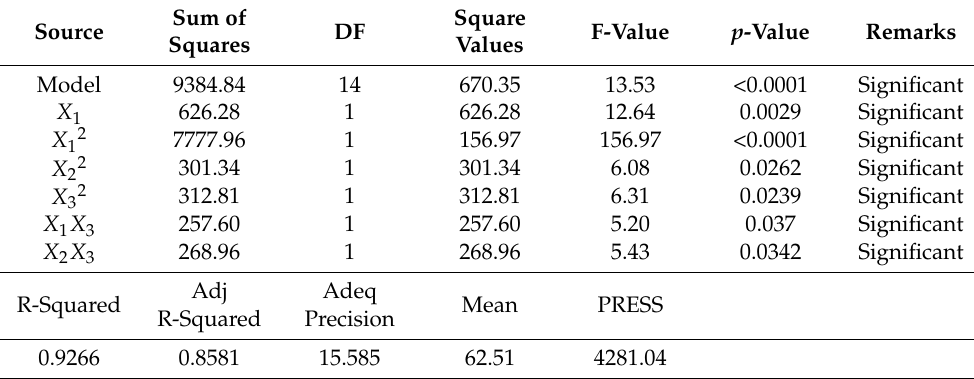
Figure 13. Optimum percentage degradation of Basic Orange 2 dye under the interaction of pro- cess variables. Table 3. ANOVA of percentage degradation of Basic Orange 2